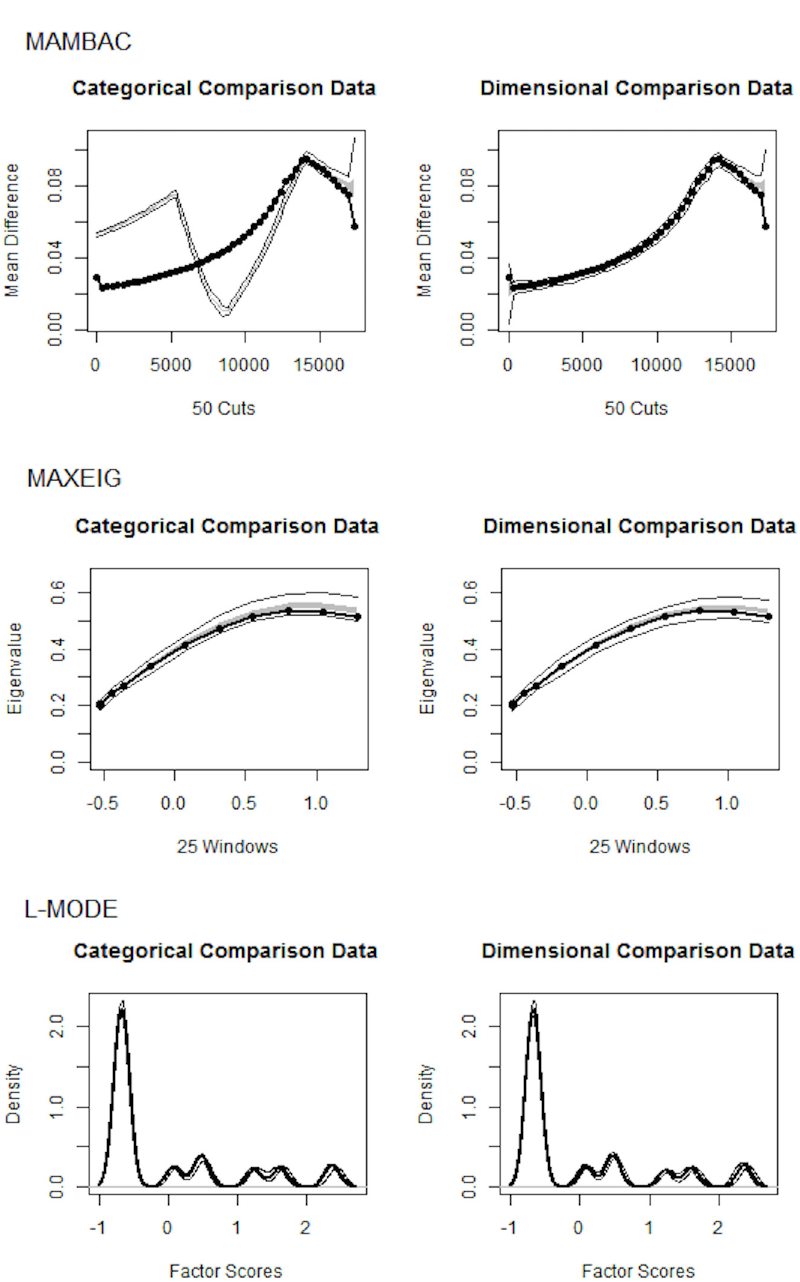
Fig 2. Taxometric Analyses of Minimization and Denial Items. Top row: left panel — average MAMBAC curve for the observed data (dark line) in comparison to simulated taxonic data (light lines representing one standard deviation above and below the mean); right panel — average MAMBAC curve for the observed data (dark line) in comparison to simulated dimensional data (light lines representing one standard deviation above and below the mean). Middle row: left panel — average MAXEIG curve for the observed data (dark line) in comparison to simulated taxonic data (light lines representing one standard deviation above and below the mean); right panel — average MAXEIG curve for the observed data (dark line) in comparison to simulated dimensional data (light lines representing one standard deviation above and below the mean). Bottom row: left panel — average L-Mode curve for the observed data (dark line) in comparison to simulated taxonic data (light lines representing one standard deviation above and below the mean); right panel — average L-Mode curve for the observed data (dark line) in comparison to simulated dimensional data (light lines representing one standard deviation above and below the mean). Inverted U-shaped graphs for the MAMBAC procedure, peaked graphs for the MAXEIG procedure, and bimodal distributions of factor scores for the L-Mode procedure are all suggestive of taxonic structure.